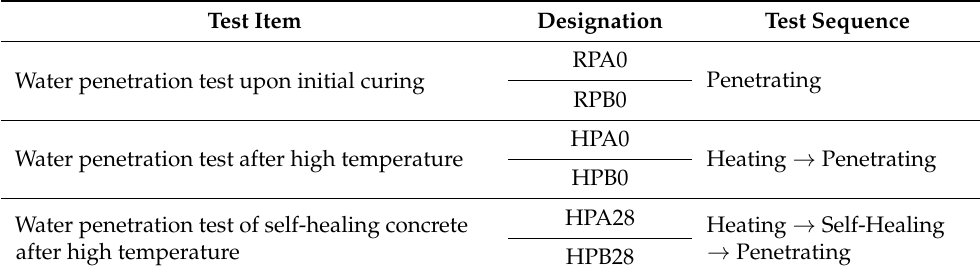
Table 5. Water penetration test items and test sequence.